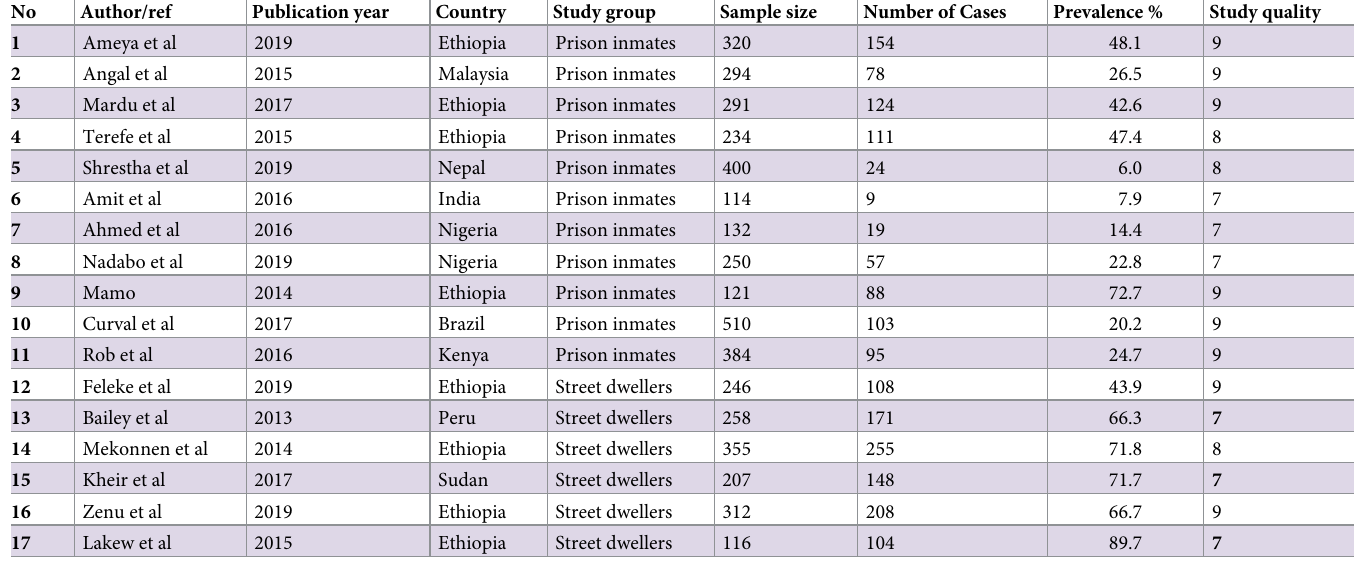
Table 1. Characteristics of included studies in the systematic review and meta-analysis of intestinal parasitic infection among street living people and prison